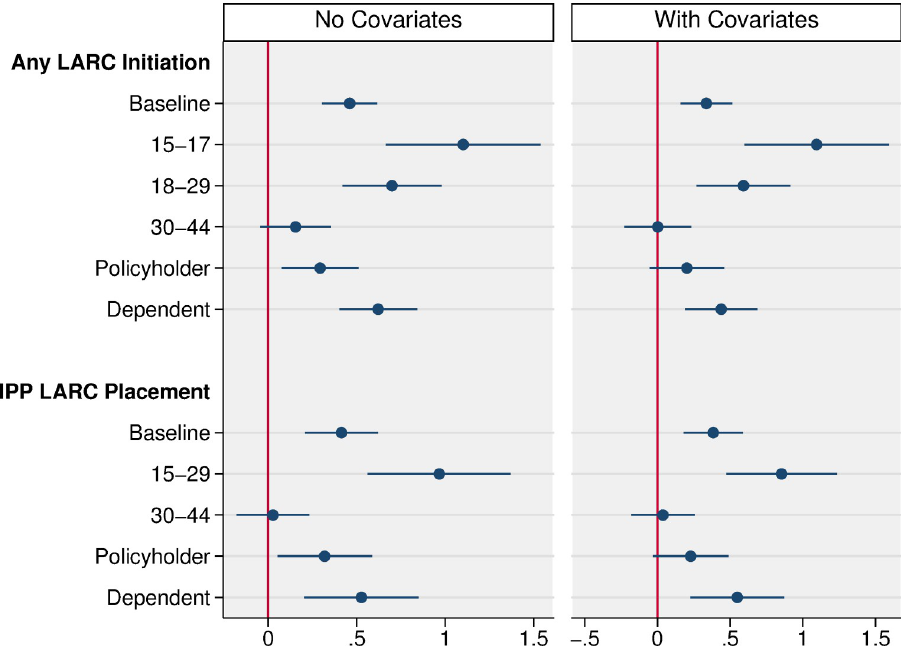
Fig 2. Difference-in-differences effect of the DelCAN program on LARC insertions, for women age 15–44 by age group and policyholder status. Source: IBM Marketscan Commercial Claims and Encounters Database (2012–2019). Notes: Difference-in-differences estimates are from a linear probability model estimated with individual data at the person-year level for any LARC insertions and at the birth level for IPP LARC placements. Both the unadjusted and adjusted difference-in-difference estimates include state and year fixed effects. The adjusted model controls for individual level covariates and state by year covariates for demographics, health care access, and other state contraceptive policies. See the text for sample inclusion rules and full list of covariates. Standard errors are clustered at the individual level and 95% confidence intervals are shown.